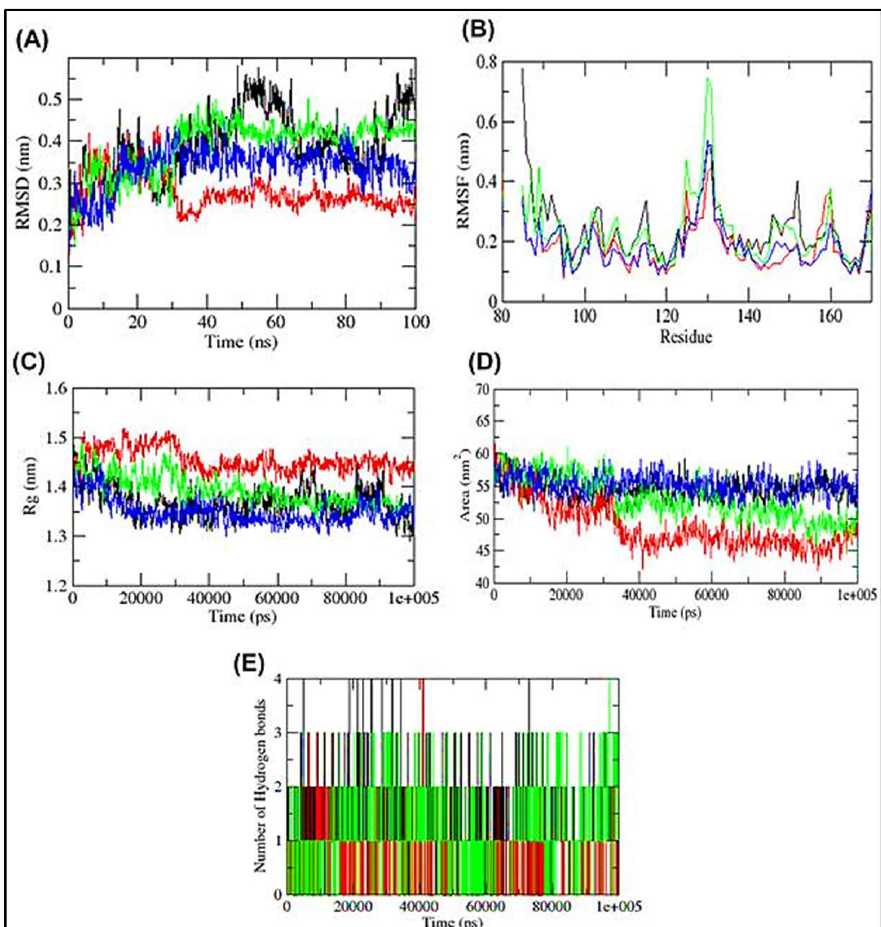
Figure 5. Molecular Dynamics Simulation of HSP27 Apo protein (black), BVDU (red), FR180204 (green) and XAV-939 (blue) over a simulation run of 100 ns. ( A ) RMSD ( B ) RMSF ( C ) Radius of gyration (Rg) ( D ) Solvent Accessible Surface Area (SASA) ( E ) Number of Hydrogen bonds during the MDS run of BVDU (black), FR180204 (red) and XAV-939 (green). Consistent with this, the analysis of RMSF against HSP27 residue number